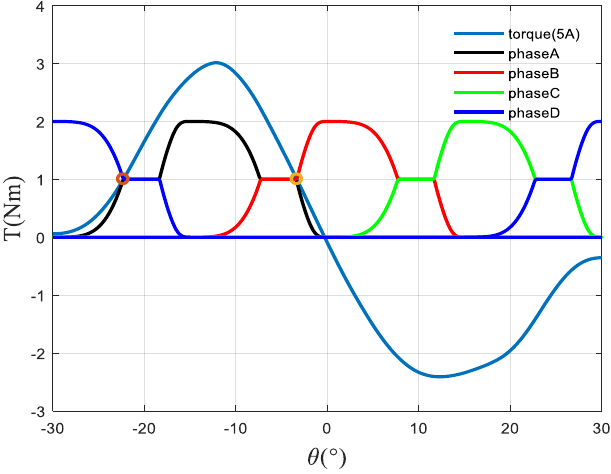
Figure 7. Torque plan waveform.